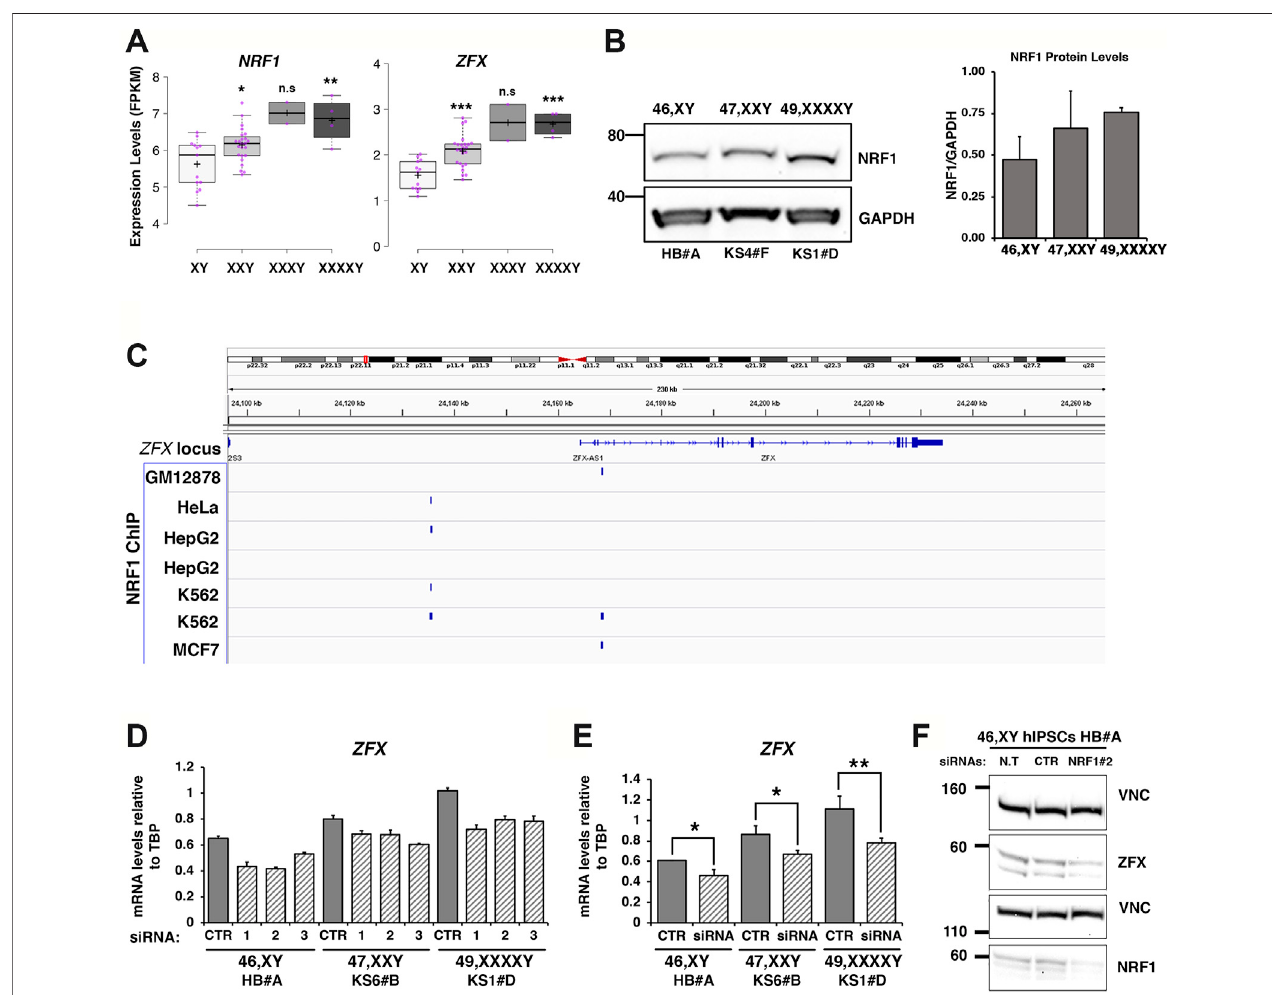
FIGURE 7 | The X dosage-sensitive autosomal TF NRF1 regulates ZFX transcriptional levels. (A) FPKM expression values of NRF1 and ZFX TFs in iPSCs in the indicated karyotypes. Each purple dot represents an independent biological RNA-Seq sample. Centerlines show the medians; box limits indicate the 25th and 75th percentile. The signi fi cance between the comparison XXY ( n (cid:1) 24) versus XY ( n (cid:1) 13) and XXXXY ( n (cid:1) 4) versus XY ( n (cid:1) 13) was calculated using the two tailed Student ’ s t-test,* p < 0.05;** p < 0.01;*** p < 0.001. (B) Lysatesfrom46,XY(HB#A), 47,XXY(KS4#F),and49,XXXXY(KS1#D)iPSCswereimmunoblottedwiththeindicated antibodies. Quanti fi cation of NRF1 protein levels relative to GAPDH expression was performed using ImageJ (right panel). Error bars are ± standard deviations of two independentexperiments. (C) NRF1ChIP-SeqtracksshowingthelocalizationofNRF1atthe ZFX locus.NRF1peakswithin-30 Kband+10 KbfromtheZFXgenebody are shown (blue rectangles). The ChIP-Seq tracks were downloaded from the ENCODE portal (https://www.encodeproject.org/) with the following identi fi ers: ENCFF931XAL, ENCFF002CSW, ENCFF003GNY, ENCFF972NIR, ENCFF144PPR, ENCFF493ABN, ENCFF651PWG). (D) Graph showing the mRNA expression levels of ZFX measured for the indicated iPSC linesand genotypes transfected with a scramble siRNA (CTR) and three different siRNAs targeting NRF1 (siRNA 1, 2, and 3) ( Supplementary Table S13 ). (E) Graph showing the average of two independent knockdown experiments performed on the indicated iPSCs lines transfected with eitherCTRorNRF1siRNAnumber2.Student ’ s t -tests,* p < 0.05;** p < 0.01;and*** p < 0.001. (F) WesternBlotshowingthedown-regulationofNRF1andZFXproteins in a 46,XY iPSC line using a siRNA targeting NRF1 (siRNA number 2); Vinculin protein (VNC) was used as loading control. n.t., not transfected, CTR, scramble